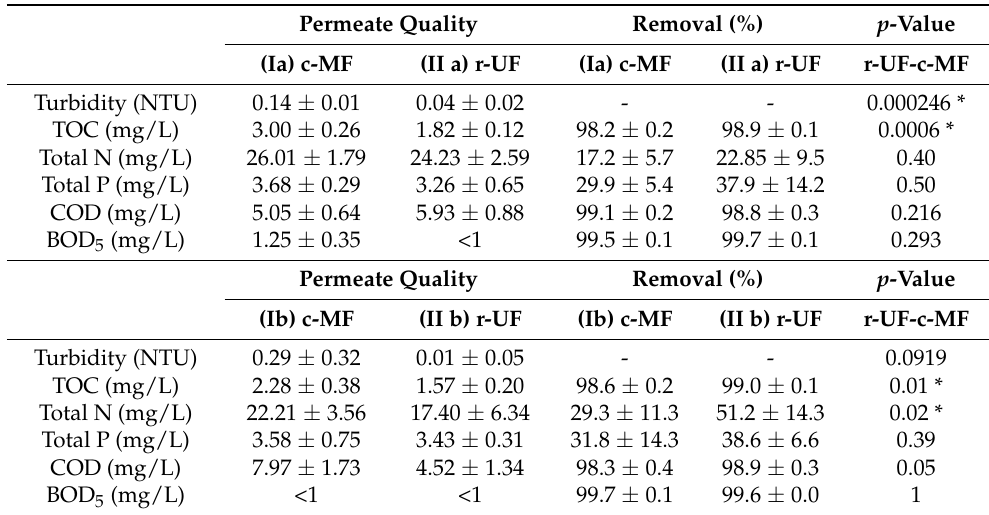
Table 2. Permeate quality and removal efficiency average values of the four different operating stages (Ia, Ib, IIa, and IIb). The p -values marked as * indicate the ANOVA results between permeate quality of the two membranes for every stage that were statistically significant with a confidence level over